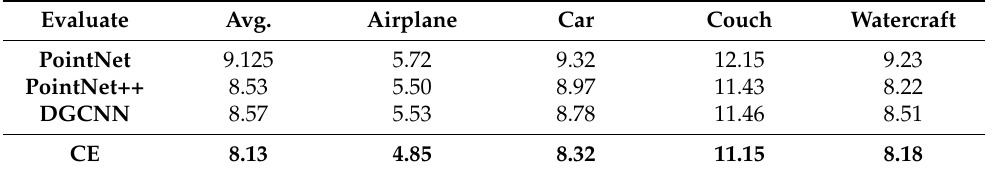
Table 4. Analysis and comparison results of different encoders in terms of per-point chamfer distance (CD) with L1 norm computed on 16,384 points and multiplied by 10 3 . The best results are highlighted in bold (lower is better).